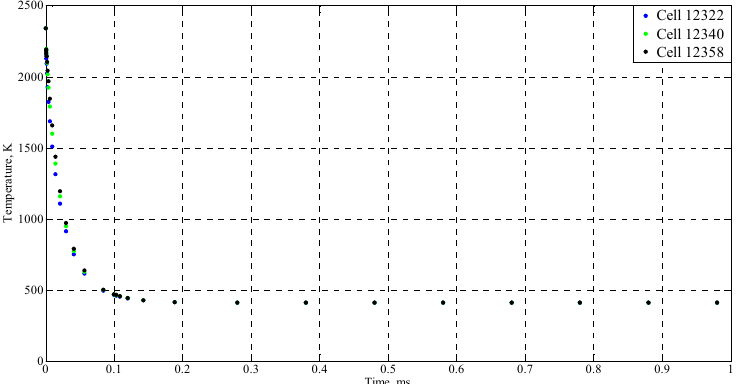
Figure 9. Temperature evolution in the splat cell 12655 with and without thermal radiation.